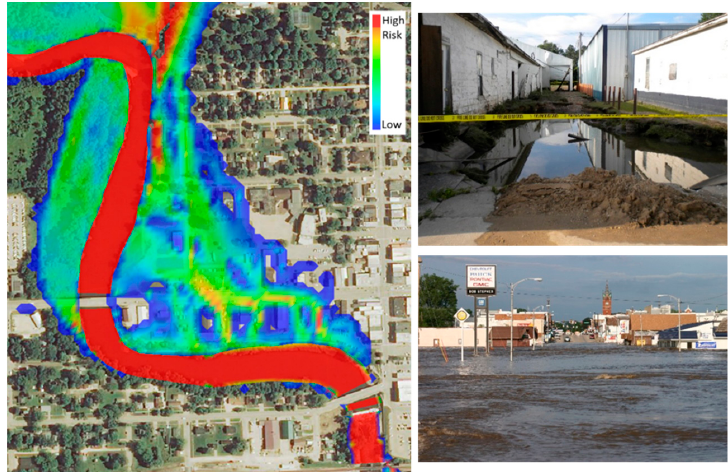
Figure 9. Maximum hazard map output from XPSWMM (XP—C2—IFC—h) for the July 2010 flood event, where red indicates high risk and blue is low risk (risk is a function of water depth and velocity computed in the model). Photos from the July 2010 flood event provided by the city show scour in between buildings and turbulent flow through downtown streets.